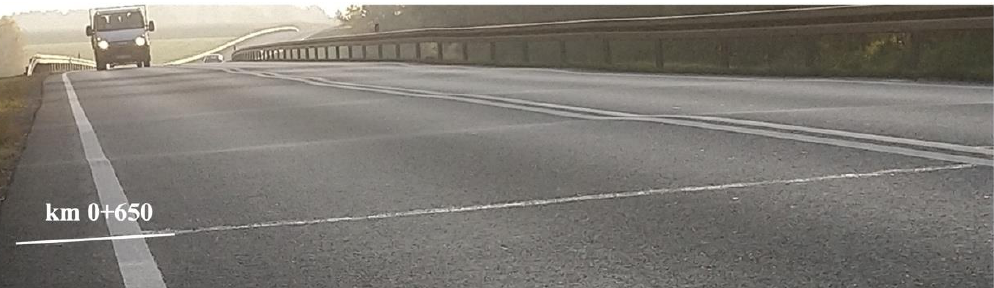
Figure 4. Example of a continuous deformation of the road surface on the section from km 0 + 680 to km 0 + 750.